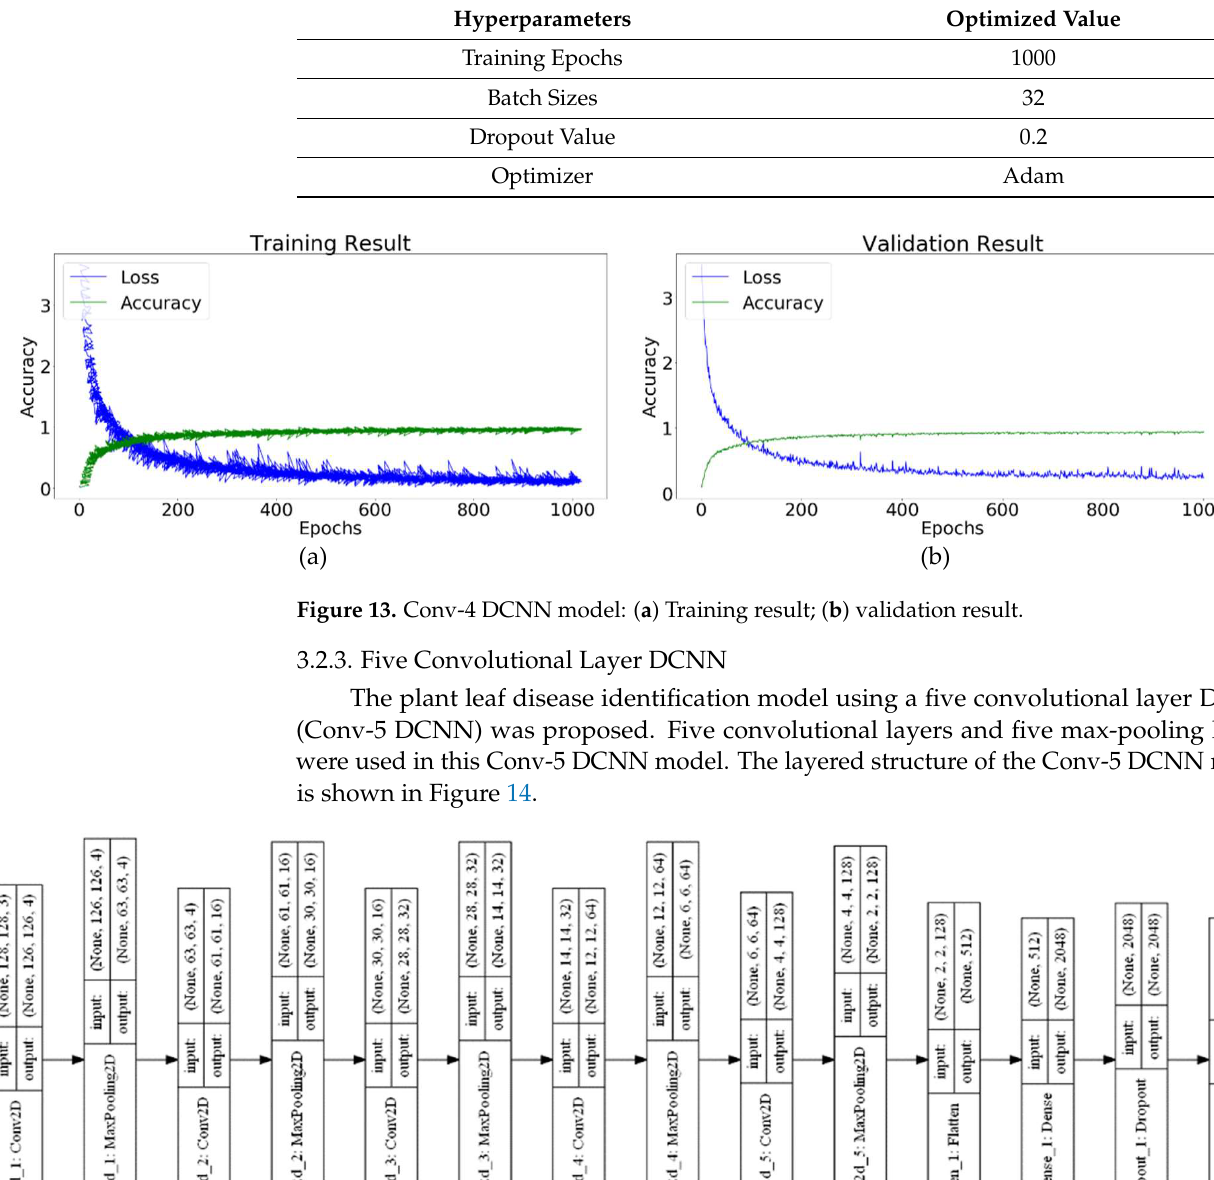
Table 4. Optimized hyperparameters of the conv-5 DCNN.